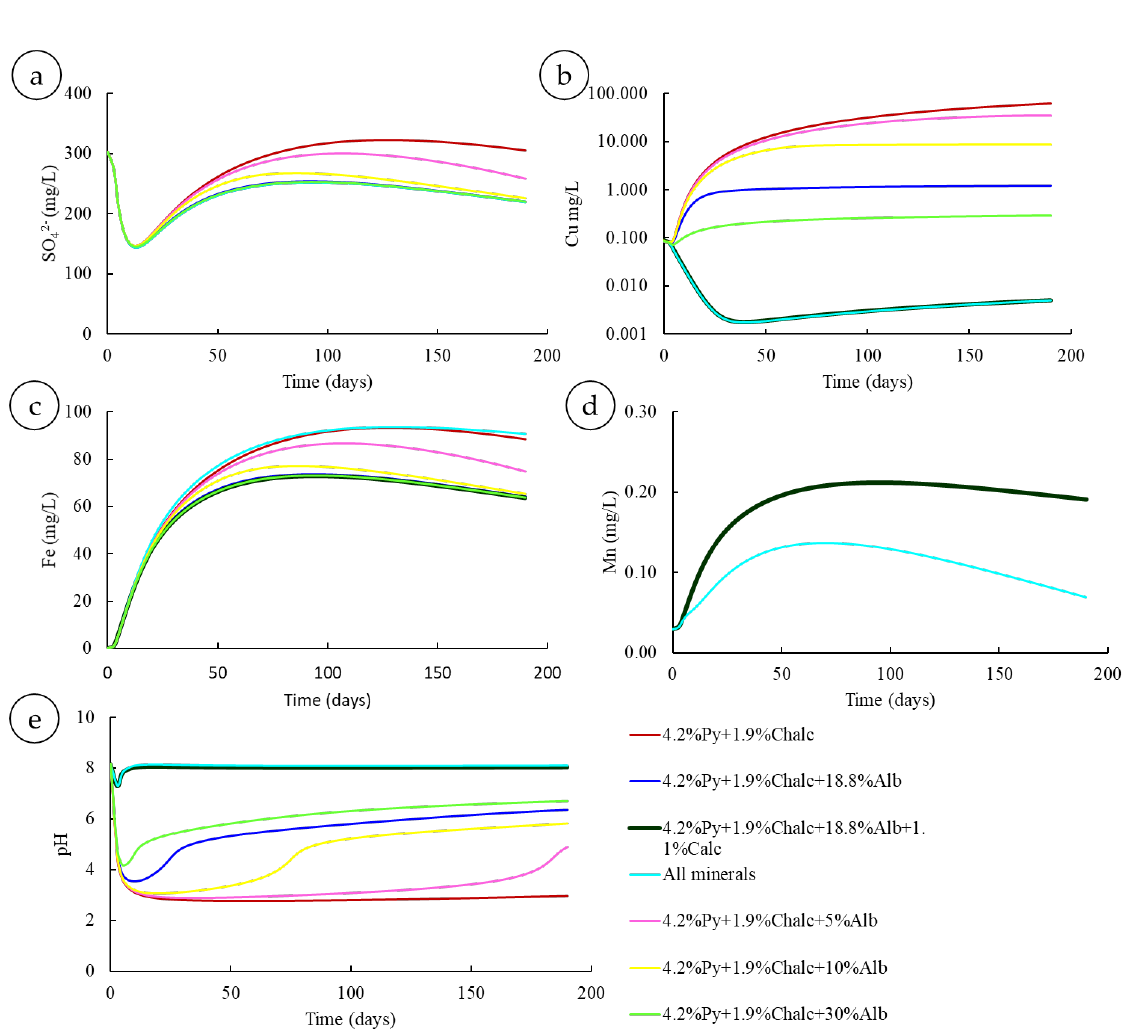
Figure 9. Various scenarios underlining the effect of various mineral assemblages on leachate quality. ( a ) Sulfate concentrations obtained in the presence of different mineral proportions. ( b ) Cu concentrations obtained in the presence of different mineral proportions ( c ) Fe concentrations obtained in the presence of different mineral proportions. ( d ) Mn concentrations obtained in the presence of different mineral proportions. ( e ) The pH obtained from the simulated mineral proportion scenarios.